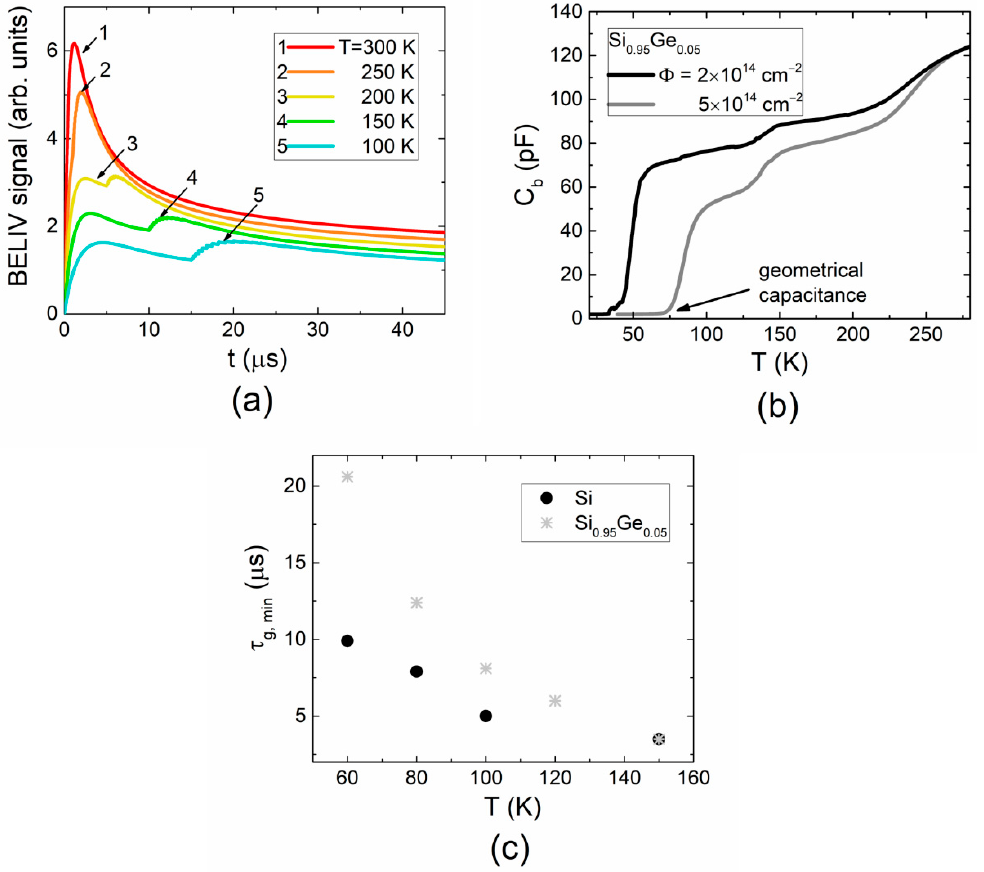
Figure 4. ( a ) Simulated variations (using Equations (1) and (3)) of the BELIV transients assuming changes of material resistivity, concentration of injected carriers, as well as minority and majority carrier traps of different generation lifetime. ( b ) Temperature-dependent barrier capacitance ( C b ) variations in diodes containing different concentration of radiation-induced traps, where C b approaches a geometrical value due to full extraction of thermally emitted carriers. ( c ) Minority carrier thermal generation lifetime as a function of temperature measured by BELIV technique in p -type Si and SiGe alloy.